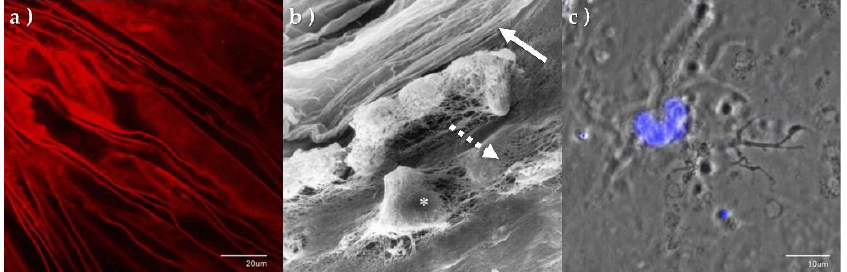
Figure 3. Immunohistochemistry and electron microscopy of PHM and laminocytes. ( a ) PHM confocal surface topography micrograph stained with collagen IV antibodies, demonstrating distinct creased appearance. ( b ) High power scanning electron micrograph of the PHM and associated laminocytes. (* laminocyte). The distinct folded vitreal aspect of the PHM (solid arrow) can be seen as a separate structure enveloping the fibrillary gel of the vitreous body (dashed arrow). ( c ) Confocal micrograph of single laminocyte reveals unique ‘large ‘cashew’ shaped nucleus. (Tissue stained with DAPI, x100.8